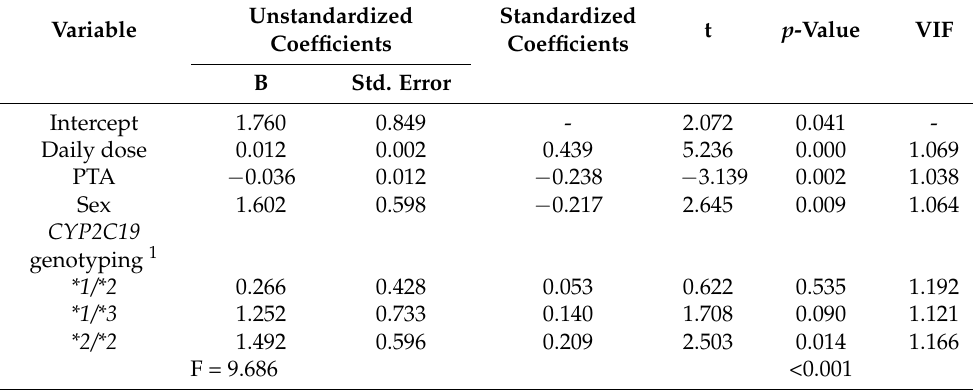
Table 4. The multiple linear regression model about voriconazole trough concentration 2